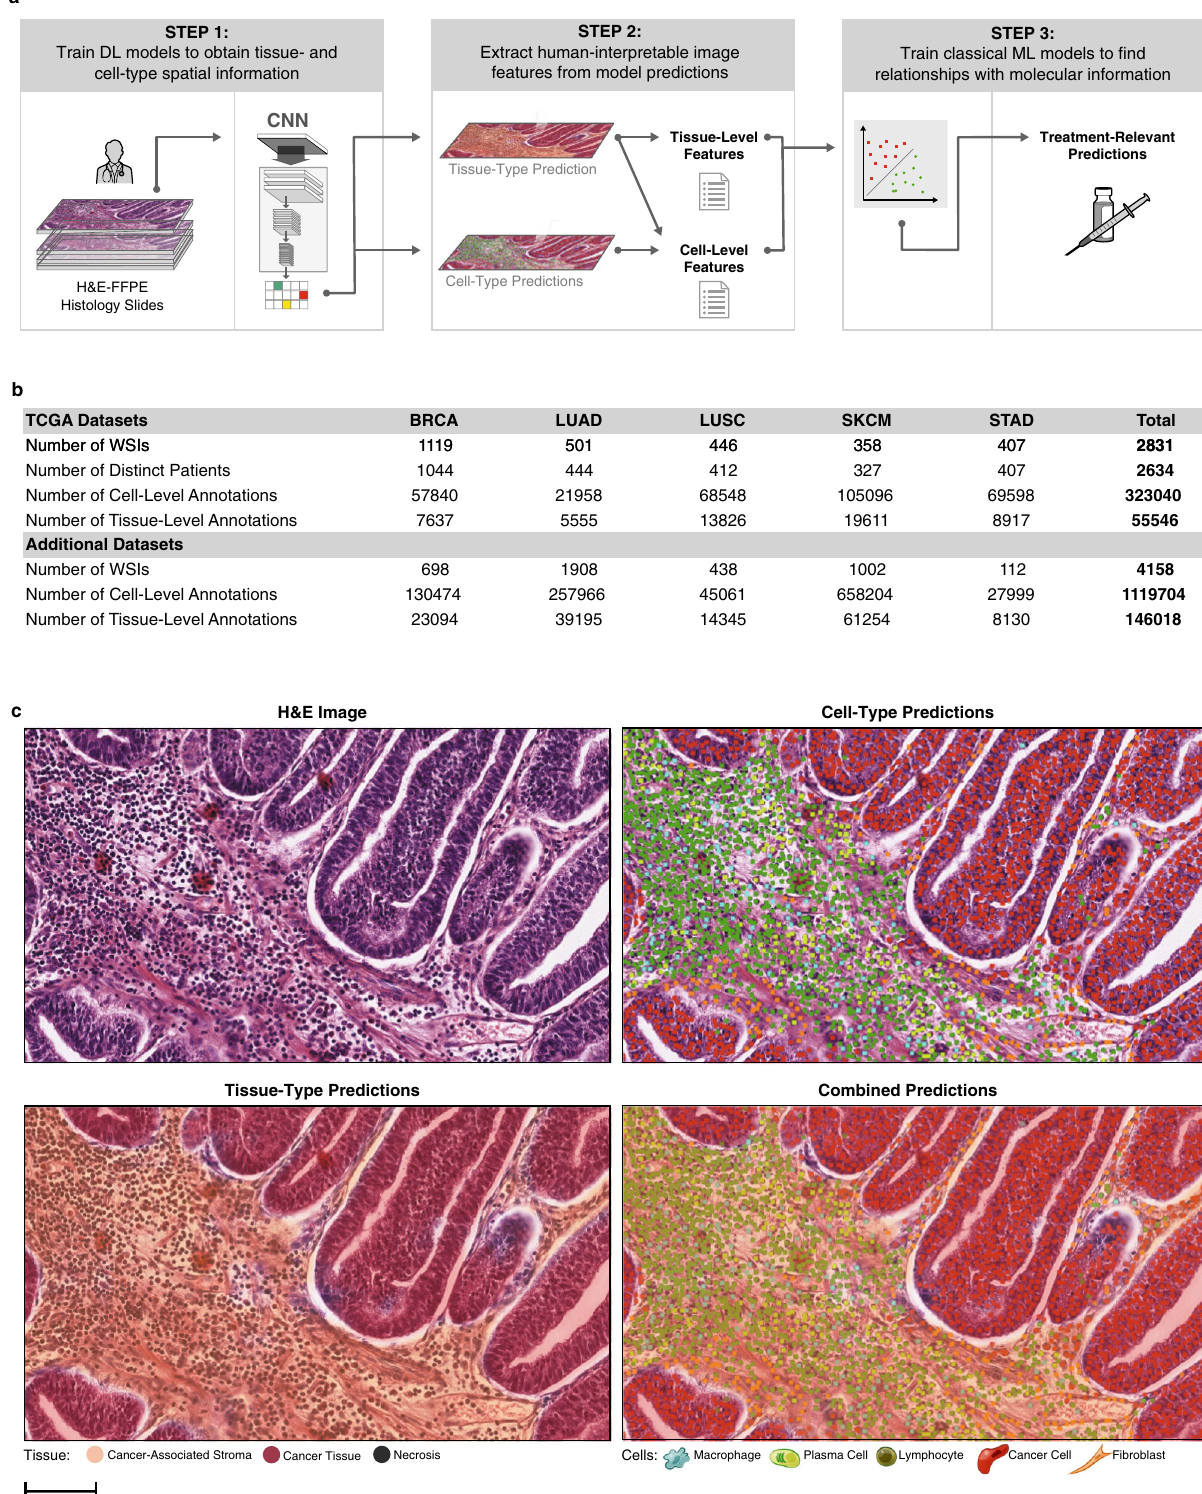
Fig. 1 Dataset and pipeline overview. a Methodology for extracting human-interpretable image features (HIFs) from high-resolution, digitized images stained with hematoxylin and eosin (H&E). b Summary statistics on the number of whole-slide images (WSIs), distinct patients, and annotations curated from The Cancer Genome Atlas (TCGA) and additional datasets. c Unprocessed portions of stomach adenocarcinoma (STAD) H&E-stained slides alongside corresponding heatmap visualizations of cell- and tissue-type predictions. Slide regions are classi fi ed into tissue types: cancer tissue (red), cancer-associated stroma (orange), necrosis (black), or normal (transparent). Pixels in cancer tissue or cancer-associated stroma areas are classi fi ed into cell types: lymphocyte (green), plasma cell (lime), fi broblast (orange), macrophage (aqua), cancer cell (red), or background